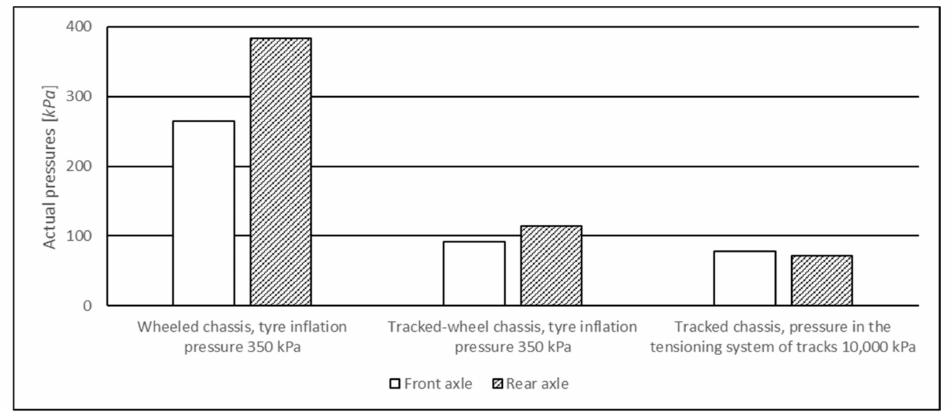
Figure 5. Average induced actual pressures in the respective chassis variants of the loaded forwarder.